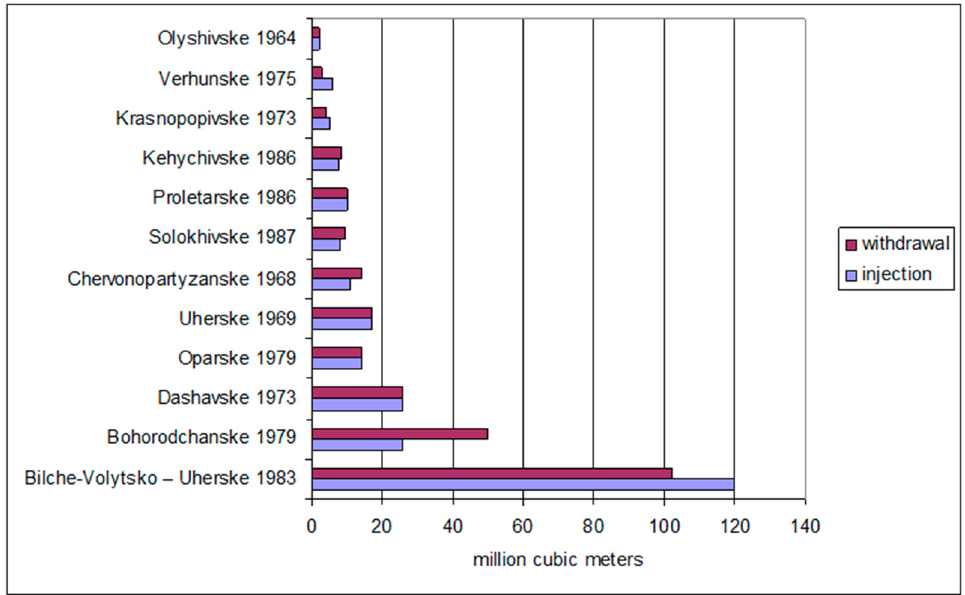
Figure 4. Characteristics of the maximum capacity of UGS of Ukraine during gas injection/with- drawal. Source: [32].